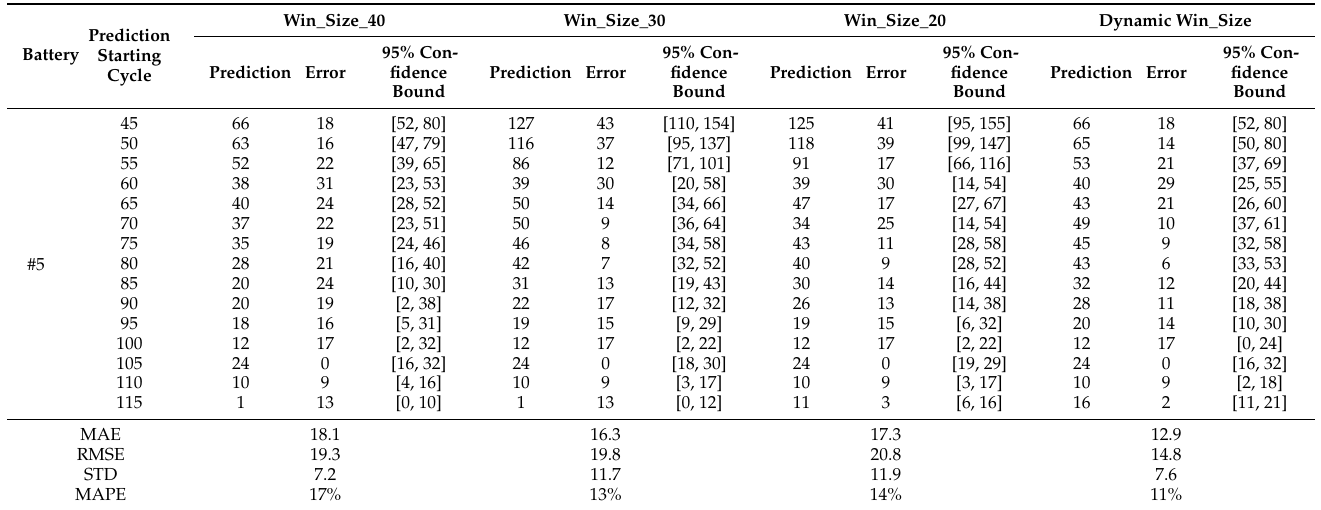
Table A1. Details of the RUL prediction results of No. 05 with different window sizes.